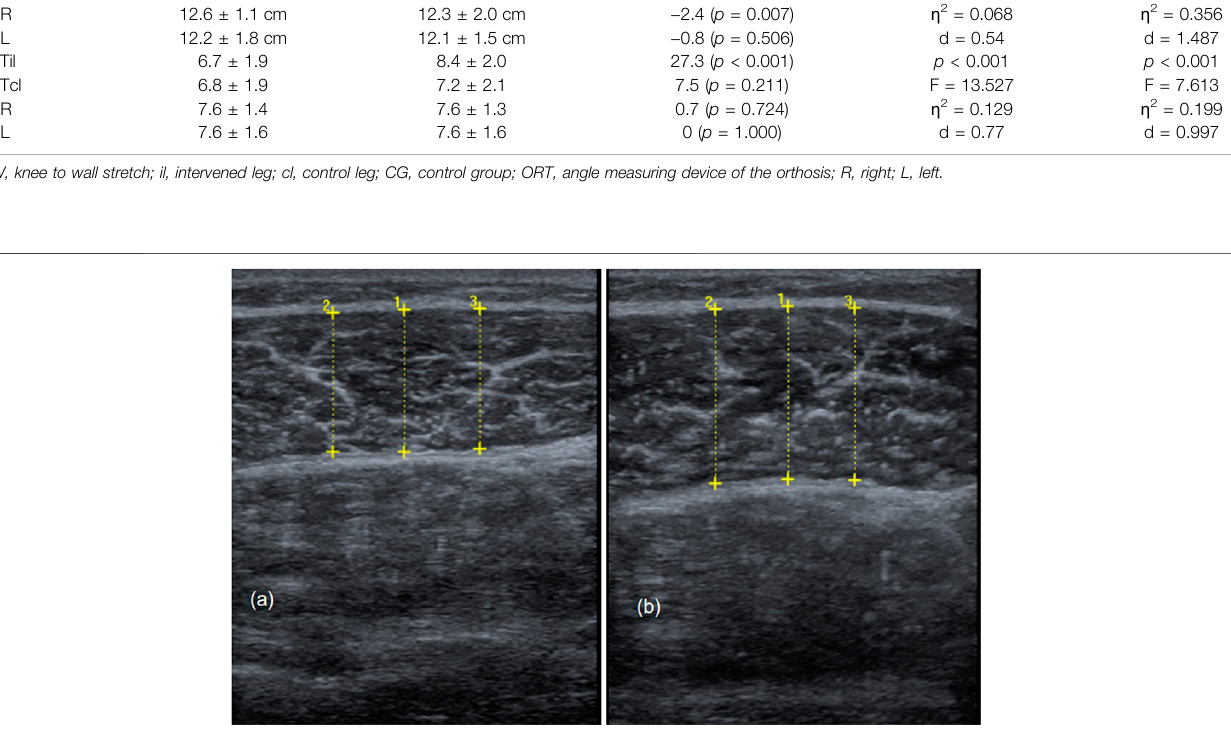
Frontiers in Physiology |